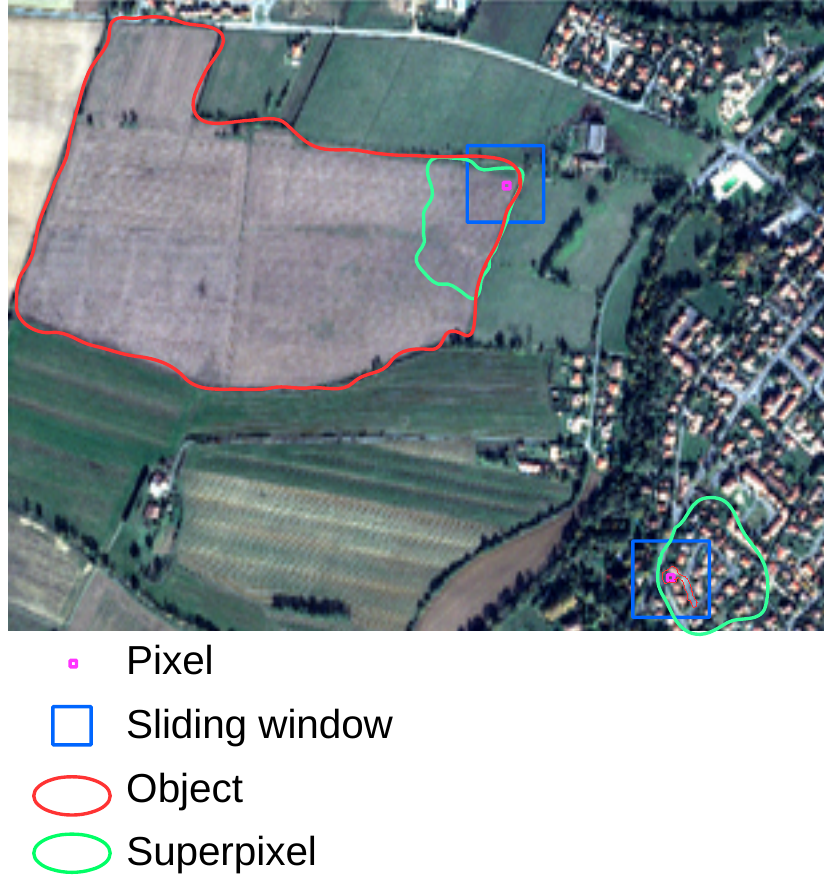
Figure 6. Illustration of the three neighborhood shapes: Sliding windows, Objects, and Superpixels over two areas with different contextual